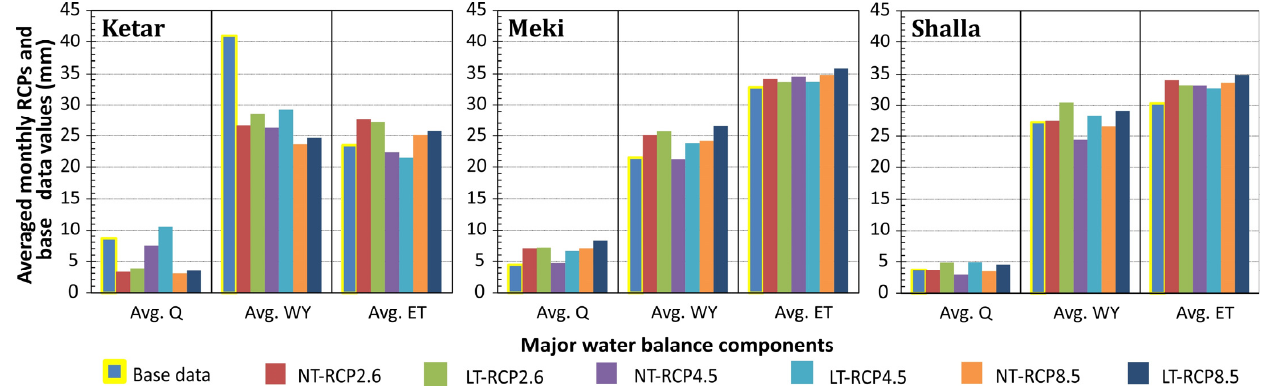
Figure 6. Monthly average values of 30 years of surface runoff (Q), water yield (WY), and evapotranspiration (ET) in the Ketar, Meki, and Shalla sub-basins for different climate scenario simulations in relation to the baseline data simulation outputs.